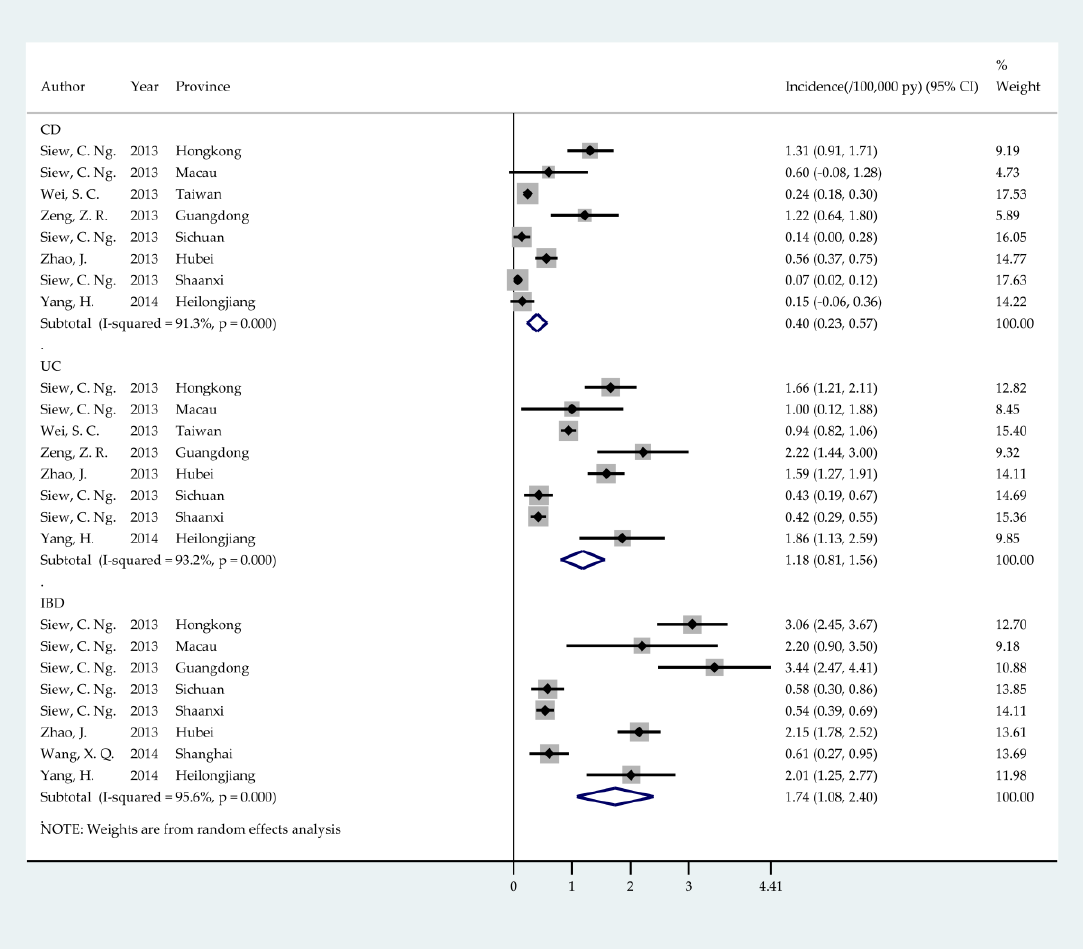
Figure 2. Forest plot for the meta-analysis of the incidence rate of inflammatory bowel disease.